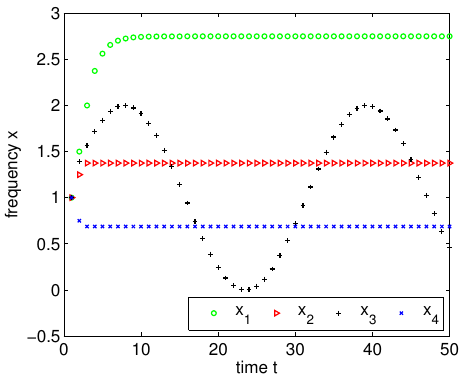
Figure 9. Frequency state versus time, where v 3 is faulty following x 3 ( t ) = 1 + sin ( t /5 )